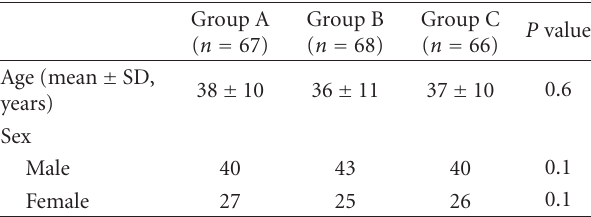
Table 1: Characteristics of patients entering the intention-to-treat analysis.